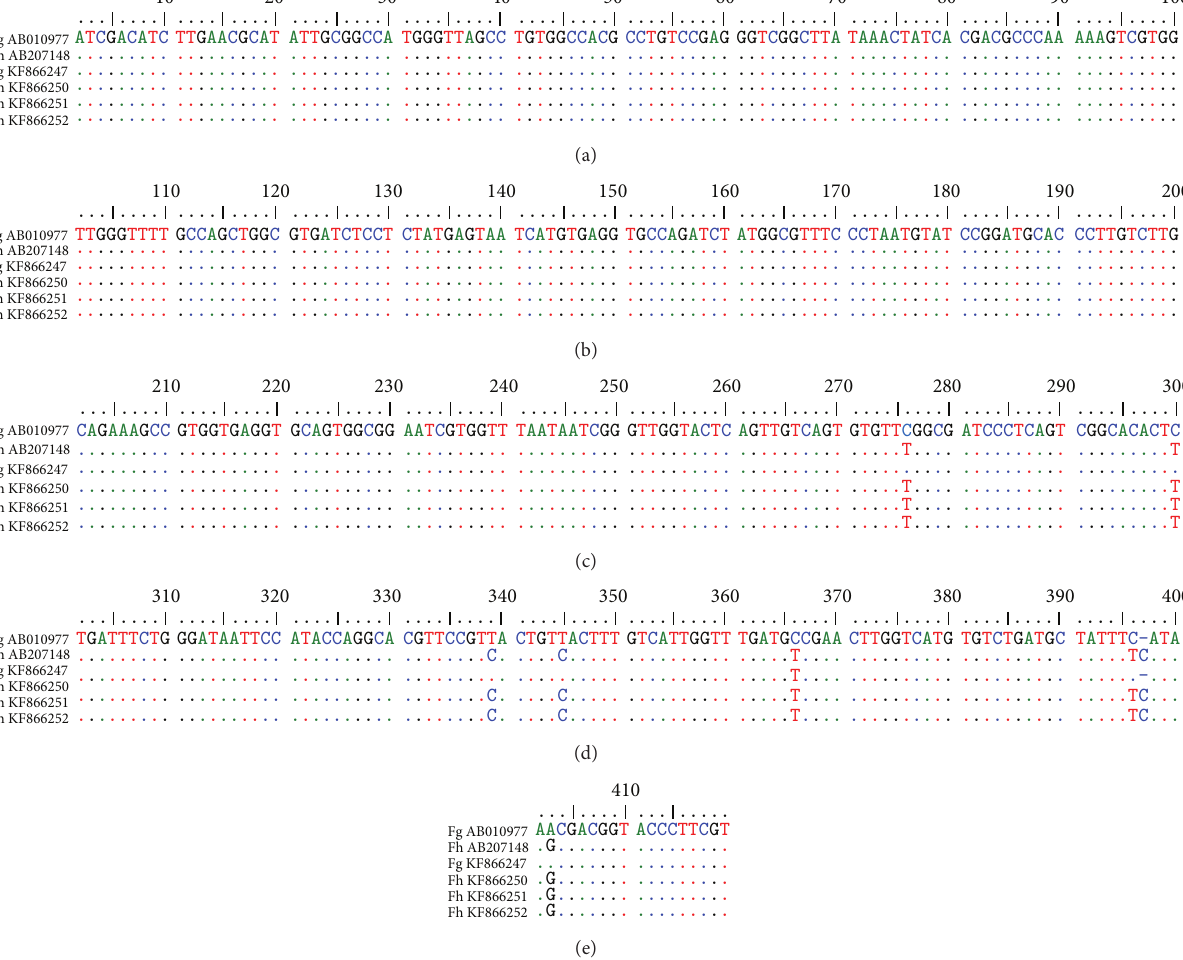
Figure 4: Alignment of ITS2 sequence of F. gigantica (AB010977) and F. hepatica (AB207148), with F. gigantica and F. hepatica of Kohgiluyeh and Boyer-Ahmad province,